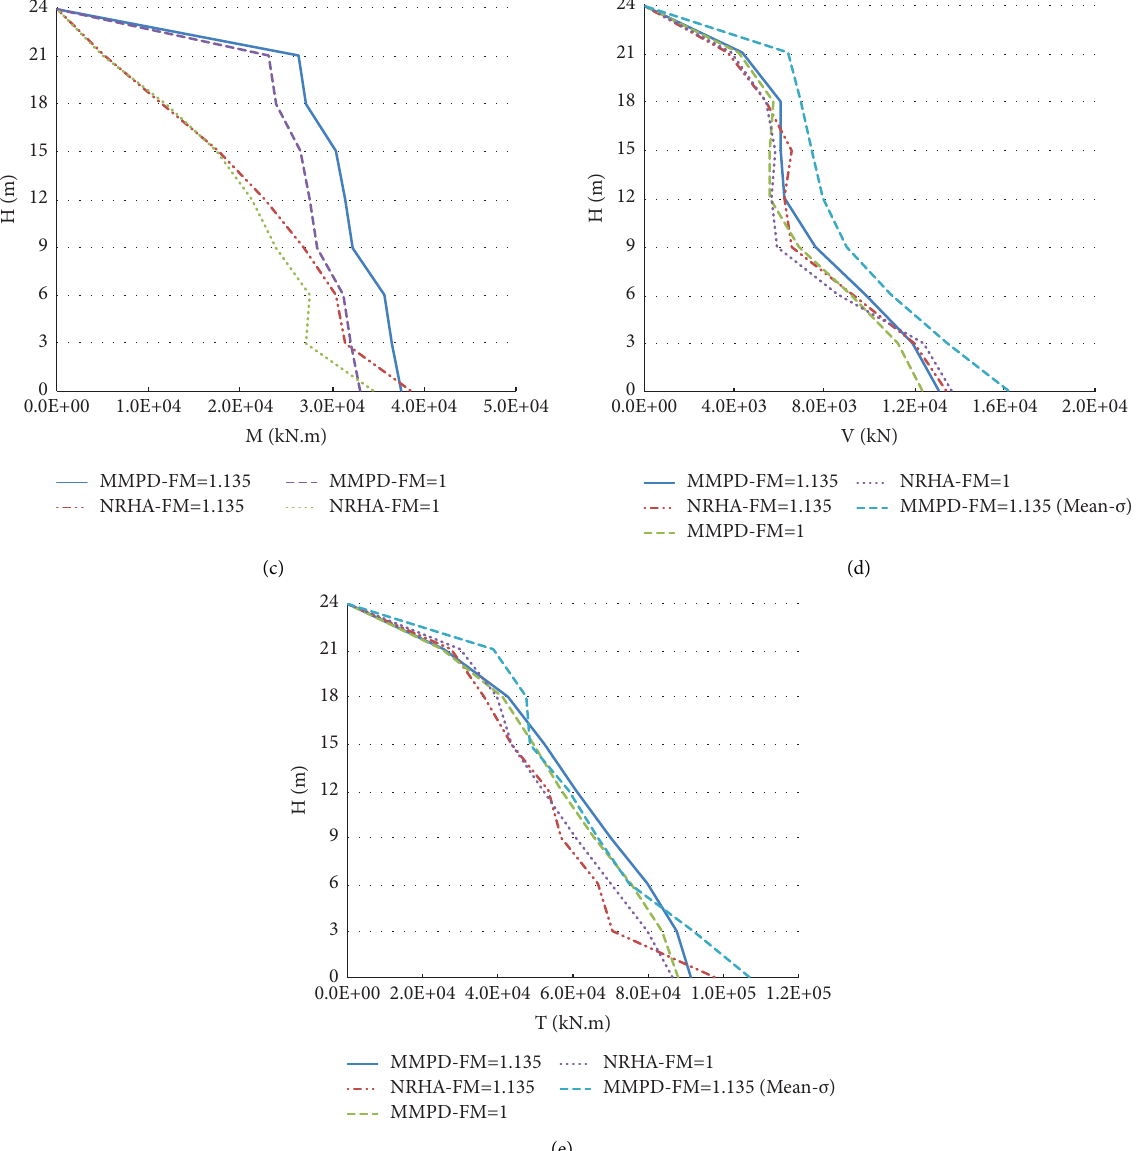
Figure 16: Building B1 under BIGBEAR record with diferent distributions of reinforcements: (a) comparison between NRHA and interstorey drifts limit, (b) NRHA fexural moment demands and MMPD fexural capacities of 30cm wall, (c) NRHA fexural moment demands and MMPD fexural capacities of 20cm wall, (d) NRHA/approximated MMPD shear demands, and (e) NRHA/approximated MMPD torsional demands using mean-matched smoothed displace- ment response spectrum + standard deviation curve at 12- and 6-meters height, which is − 28.25% and − 10% diference relative to NRHA shear demands (Figures 19 and 22).